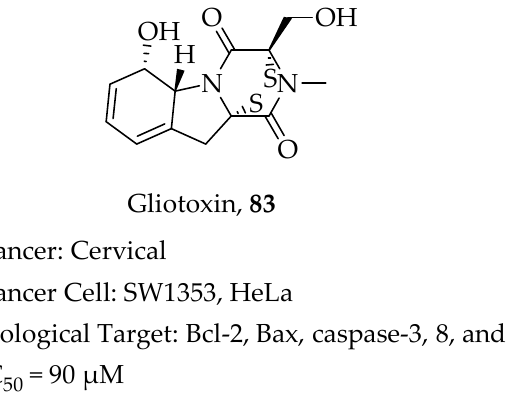
Figure 16. Chemical structure of Gliotoxin and summary of its biological activity towards selected cancer targets.